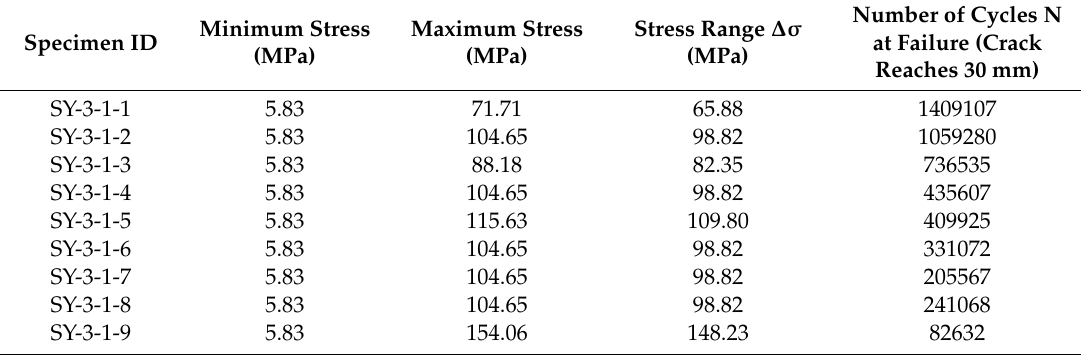
Table 3. Fatigue test results.